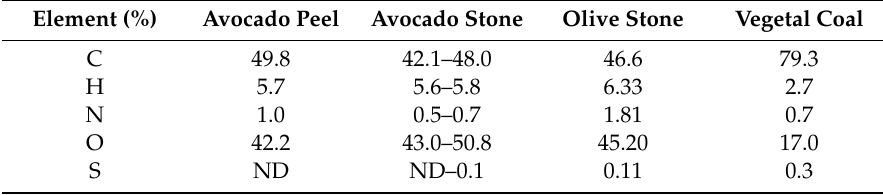
Table 2. Elemental analysis of some avocado residues and other biomasses